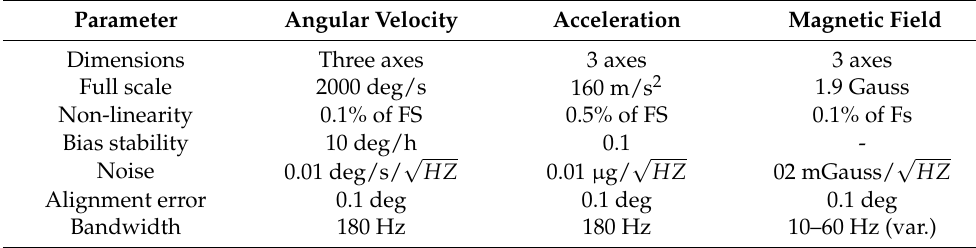
Table 1. Technical properties of MTw2 Awinda Wireless 3DOF Motion Tracker (www.xsens.com, accessed on 12 December